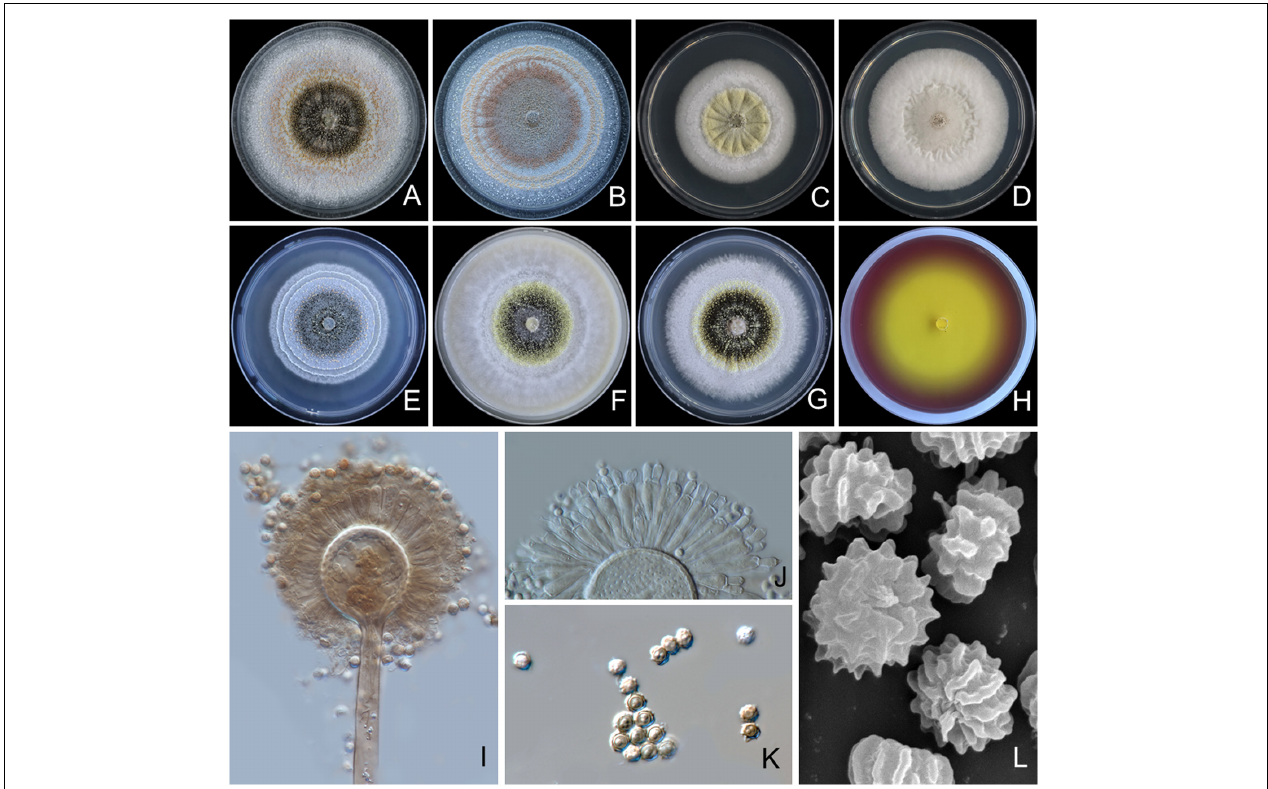
FIGURE 3 | Aspergillus pseudopiperis SDBR-CMUI1 (holotype). Colonies incubated at 25 ◦ C for 7 days. (A) PDA, (B) CZA, (C) CYA, (D) CYAS, (E) MEA, (F) OA, (G) YES, (H) CREA, (I,J) conidiophores under light microscopy, (K) conidia under light microscopy, (L) conidia as seen using SEM. Scale bars: (A–H) 10 mm, (I–K) 10 µ m, and (L) 5 µ